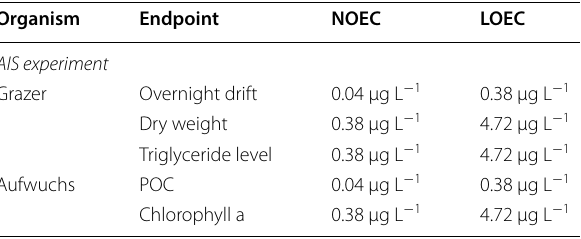
Table 6 Deduced effect concentrations of terbutryn for the AIS experiment of the different test